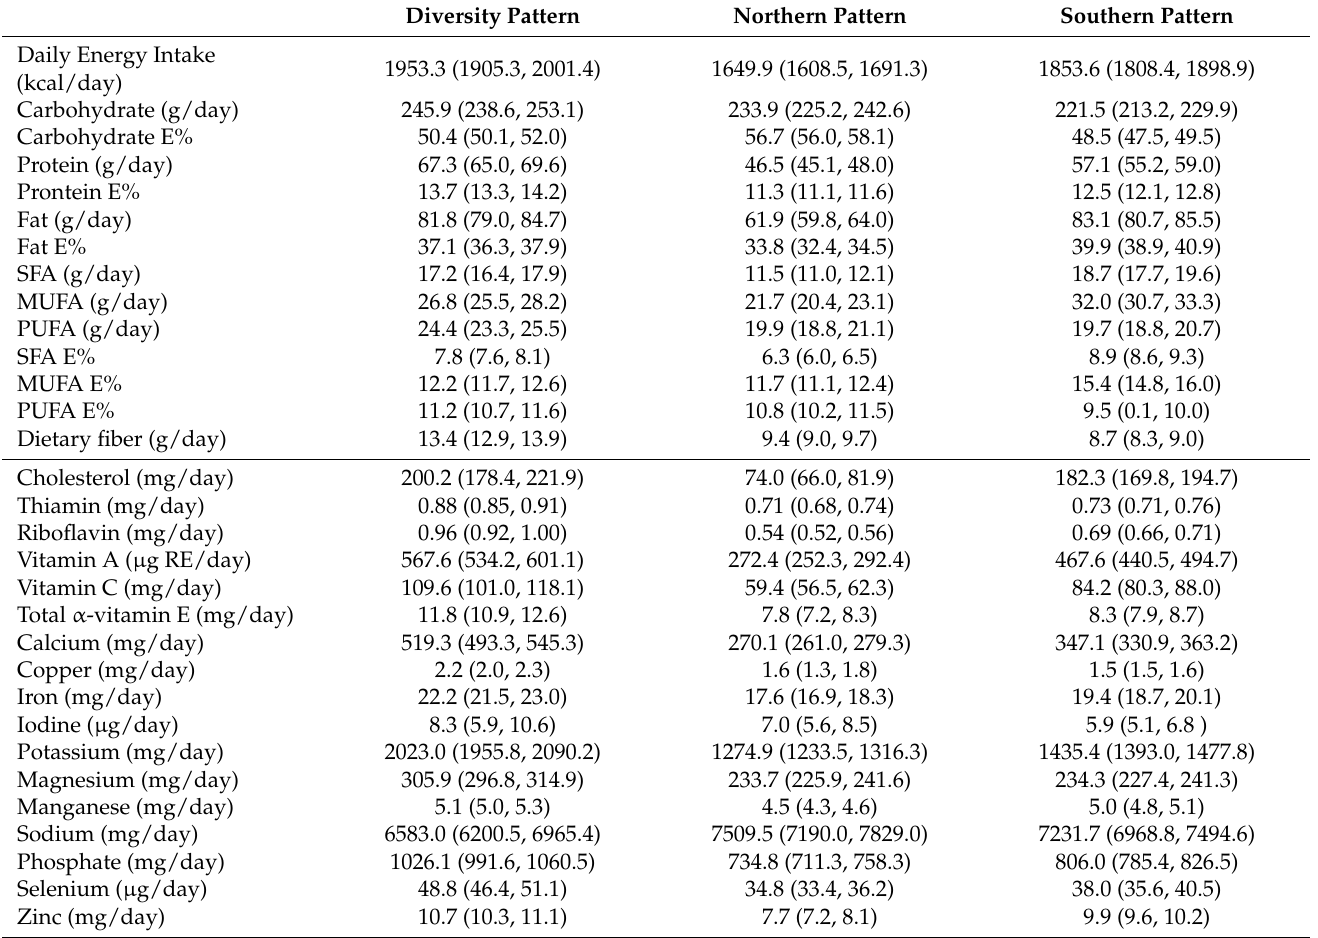
Table 4. Daily energy and nutrients intake of the three patterns among middle-aged and above participants (mean, 95%CI). Diversity Pattern